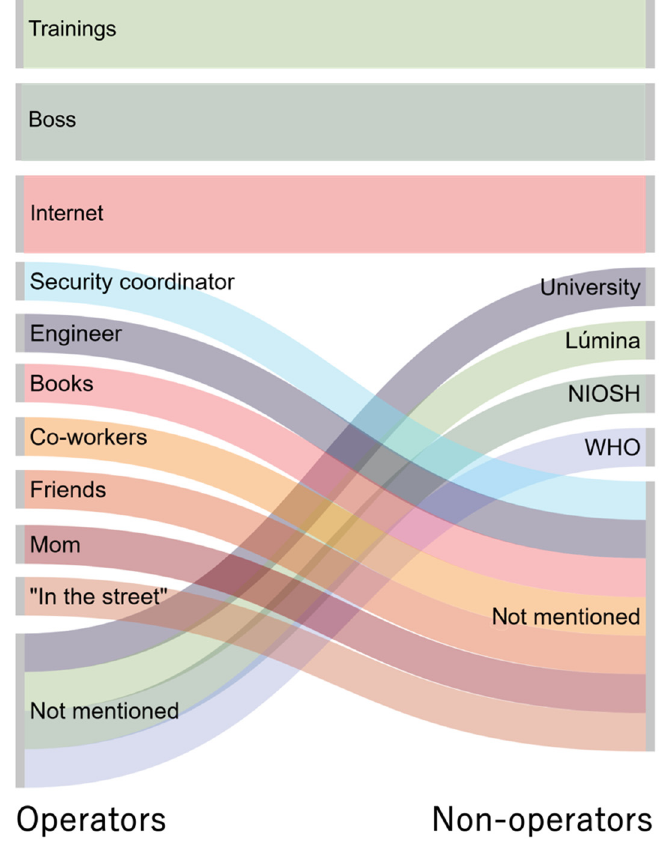
Figure 1. Operators and non-operators used different sources of information about mercury exposure, presented here in a Sankey diagram. Operators’ sources of health risk information are shown on the left; non-operators’ sources are shown on the right. Operators mentioned several informal sources not mentioned by non-operators, while non-operators referred to several additional formal sources of health information not mentioned by operators. Information from training, bosses, and the internet were mentioned most frequently in both groups and are shown in larger boxes. Warm colors indicate informal sources of information (e.g., internet searches, personal contacts) while cool colors indicate formal sources (e.g., on-site trainings, supervisors). Abbreviations: National Institute for Occupational Safety and Health (NIOSH), World Health Organization (WHO).